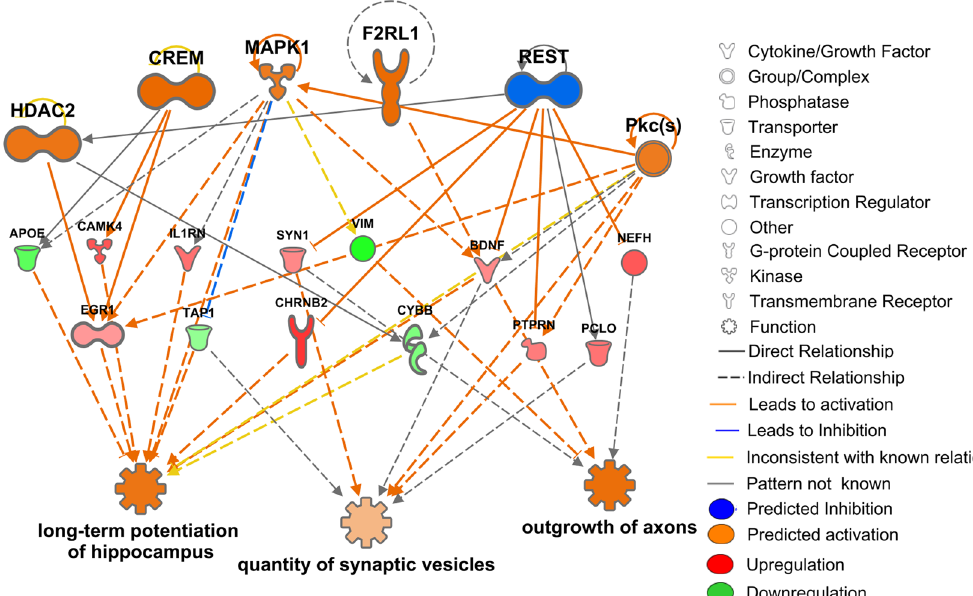
Figure 4. Upstream regulator effect analysis of nervous system related functions. The results show that pathways that regulate synaptic vesicle quantity, outgrowth of axons and long term potentiation pathways in hippocampus are up-regulated in type III cells. The colour coding and organization are as described in Fig.